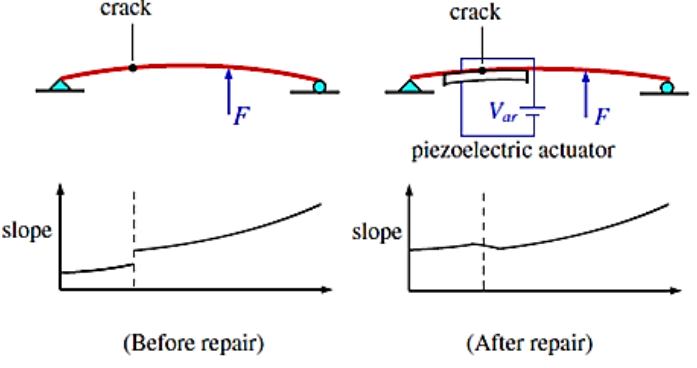
Figure 3. Slope continuity criterion for active repair